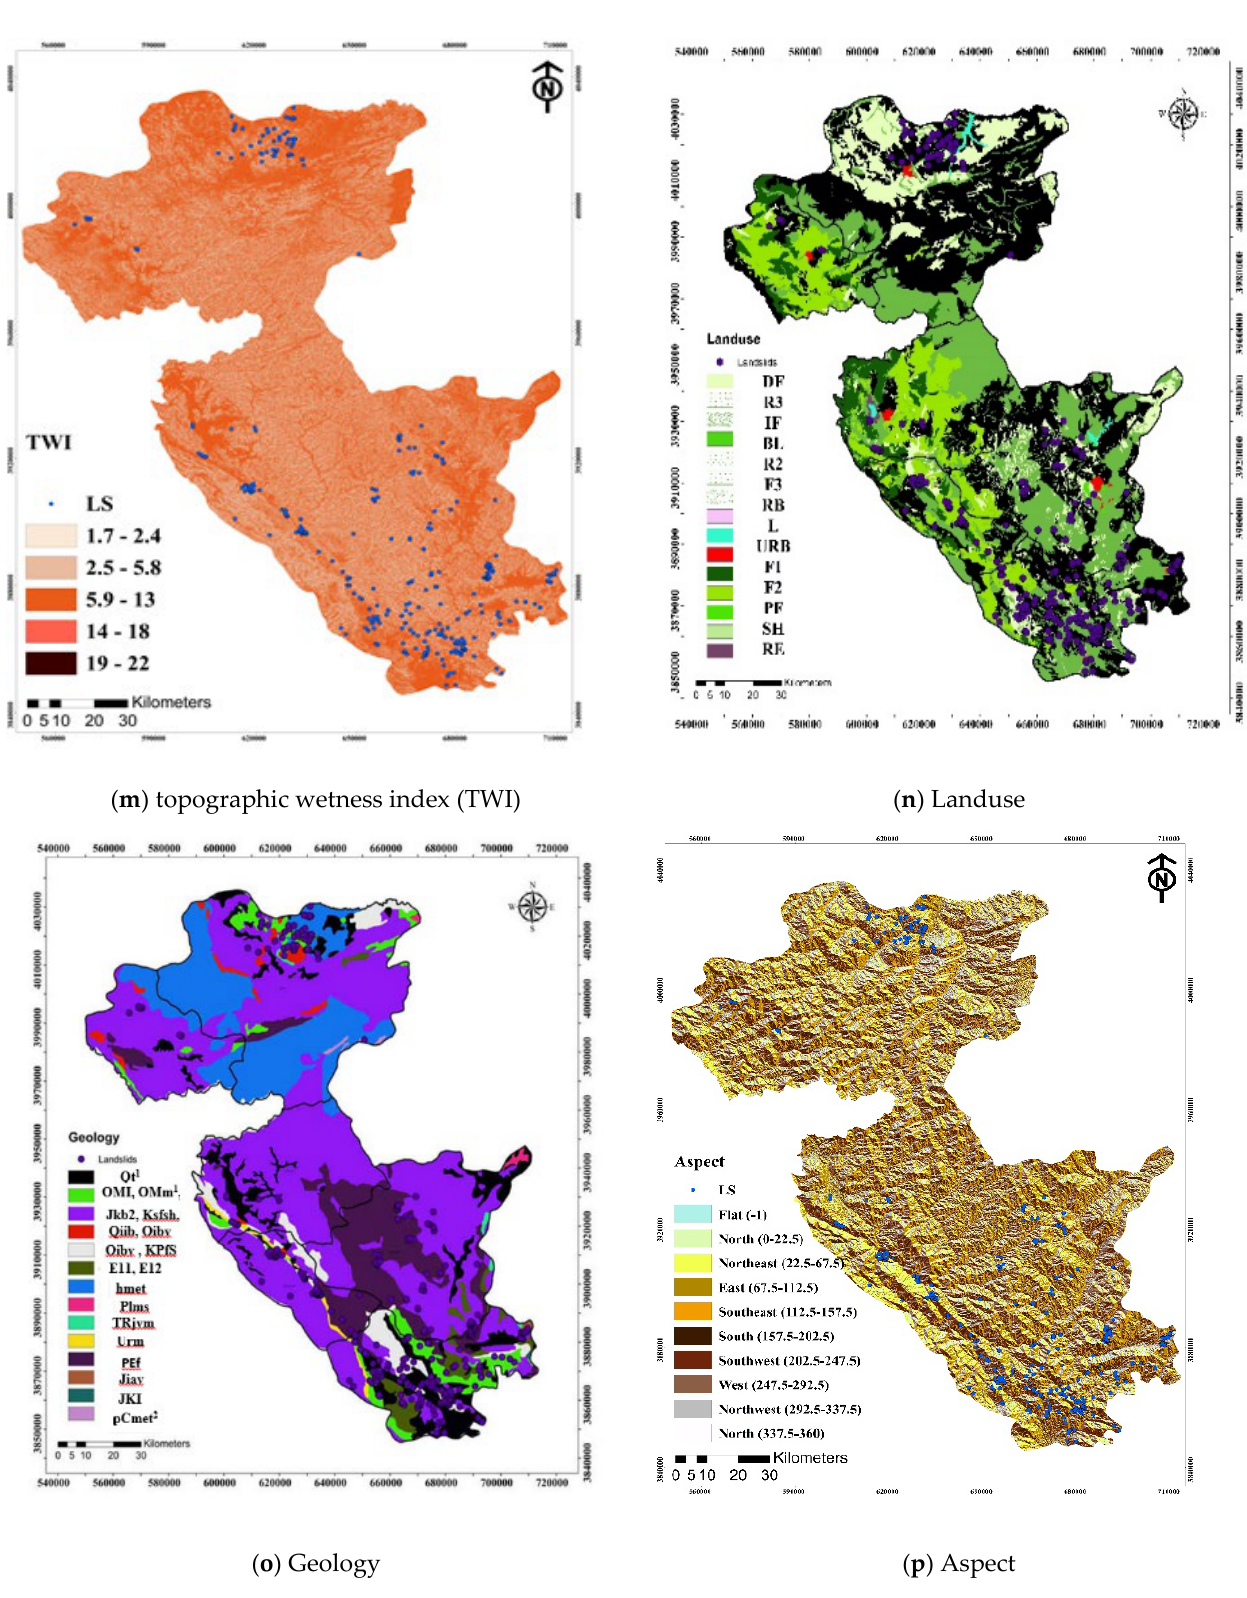
Figure 6. Maps of landslide conditioning factors in the study area. Table 1. Landslide conditioning factors and their class.